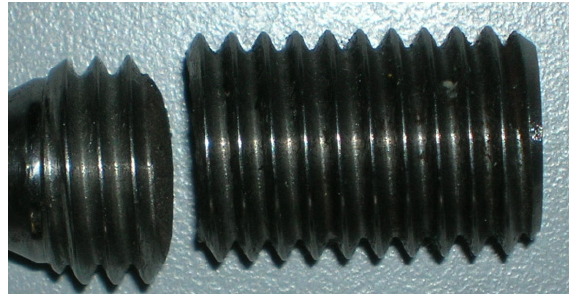
Figure 3: Fractured head of a fatigue